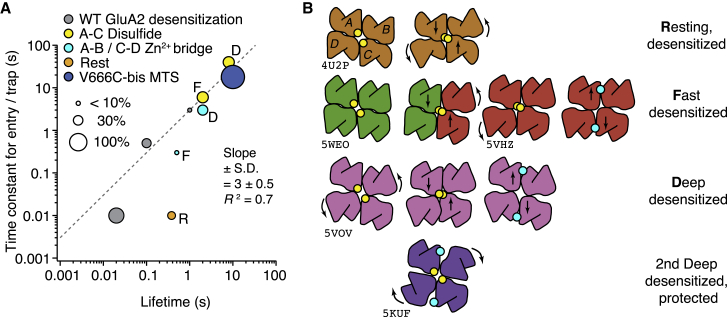
Models of trapping in desensitized states. (A) The time constants of trapping and entry to desensitization are plotted against desensitized or trapped state lifetimes. The symbol sizes represent the fraction of receptors trapped as indicated. Entry time constants depend on condition (zinc concentration, bis-MTS concentration), hence the linear relation has little physical meaning. Entry time constants for trapping were estimated from the midpoints of exponential fits to lifetimes. The time constants of entry, recovery, and the fractions for WT GluA2 are estimated from the data in Fig. 5E. See the text for Discussion of these time constants and their putative relation to trapped states. Lettering indicates presumptive “R”esting, “F”ast, and “D”eep classes from (B). The V666C-bis-MTS point (dark blue) is from 1 μM bis-MTS trapping (21). (B) Putative LBD arrangements in four distinct classes of desensitized states were identified by cross-linking (plan view). Subunits A–D are arranged as marked on resting state. Published structures are indicated by PDB codes. Diagonal disulfide bonds are indicated by paired yellow circles, and the lateral Zn2+ bridge is indicated by a cyan circle (as in A). Fast desensitization can probably occur with one dimer active (green) and one dimer desensitized (red) after only small movements. Multiple components of trapping for both disulfides and zinc bridges require multiple states, here represented by the “Fast” and “Deep” desensitized rows (lettering from A indicated in bold here). In the second deep desensitized state, neither the A–C disulfide nor the lateral bridge can form. To see this figure in color, go online.